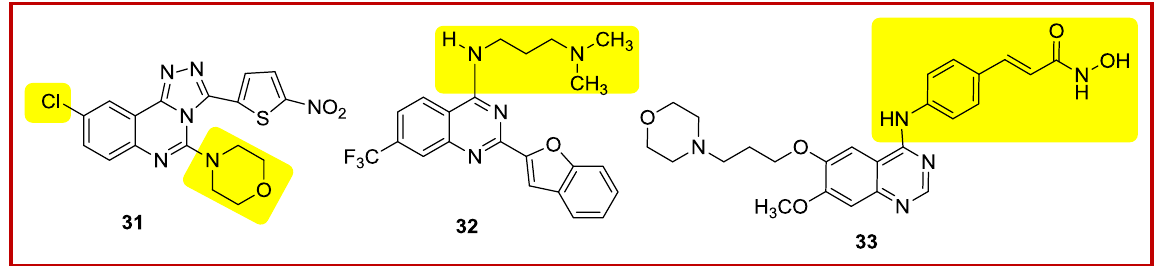
Figure 17: Representative quinazoline motifs for SAR